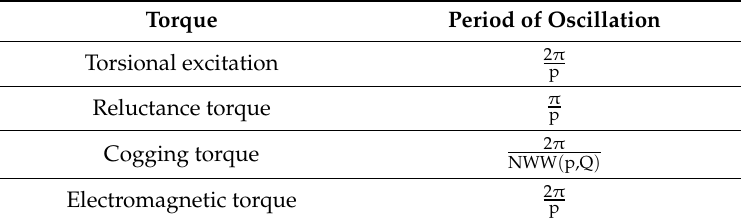
Table 1. Periods of oscillation for certain